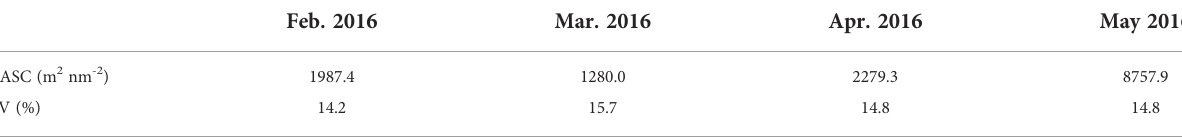
TABLE 2 Krill nautical area scattering coef fi cient (NASC) (= acoustic density), and coef fi cient of variation (CV) of the fi shing ground in the Brans fi eld Strait in February – May